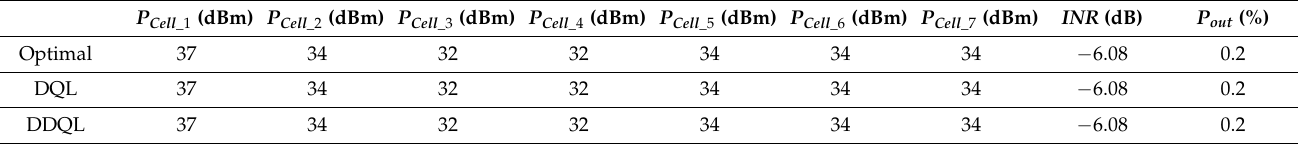
Figure 14. Reward for each learning episode for interfered receiver ② . 5.2.3. Simulation Results for Interfered Receiver ③ Figure 15 shows the SINR map based on 𝑷 (cid:3030) obtained using the proposed DQL- based power control algorithm for interfered receiver ③ . The interfered receiver was lo- cated in the azimuth main lobe direction of 𝐶𝑒𝑙𝑙_3 . It was closer to the HAPS than the receiver considered in Section 5.2.1 and was more severely affected by 𝐶𝑒𝑙𝑙_3 ; 𝐼𝑁𝑅 (cid:3047)(cid:3035) was not satisfied even for the minimum power of 𝐶𝑒𝑙𝑙_3. Thus, the optimal power control adjusted the power of 𝐶𝑒𝑙𝑙_2 and 𝐶𝑒𝑙𝑙_4 , which caused the second-most interference. Ta- ble 6 presents a comparison of the 𝑷 ∗ values obtained using an exhaustive search and 𝑷 (cid:3030) and a comparison of the DQL and DDQL results. Although the 𝑝 (cid:3042)(cid:3048)(cid:3047) of 𝑷 (cid:3030) was 0.6% higher than that of 𝑷 ∗ , it corresponded to the third-smallest value among the 78,125 val- ues generated by the exhaustive search algorithm. In summary, the proposed power con- trol algorithm achieved outstanding performance close to the optimal value.